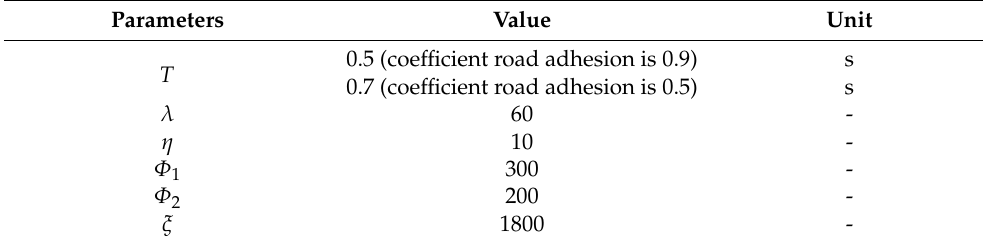
Table 1. Parameters of sliding mode controller.